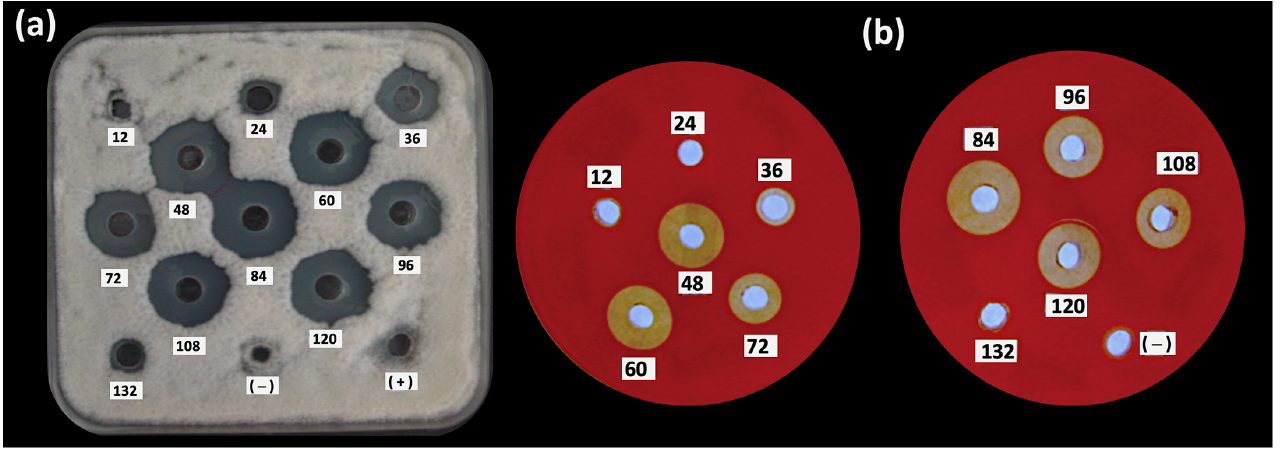
Figure 2. Kinetic of ( a ) antifungal (against C. gloeosporioides ATCC 42374) and ( b ) hemolytic activities over a period 132 h in LBMs of B. subtilis subsp. spizizenii MC6B-22. Table 4. Growth kinetic and antifungal, hemolytic, biosurfactant and bioemulsifiying activities monitored for 132 h in LBMs of Bacillus subtilis subsp. spizizenii MC6B-22. The antifungal activity shown was against C. gloeosporioides ATCC